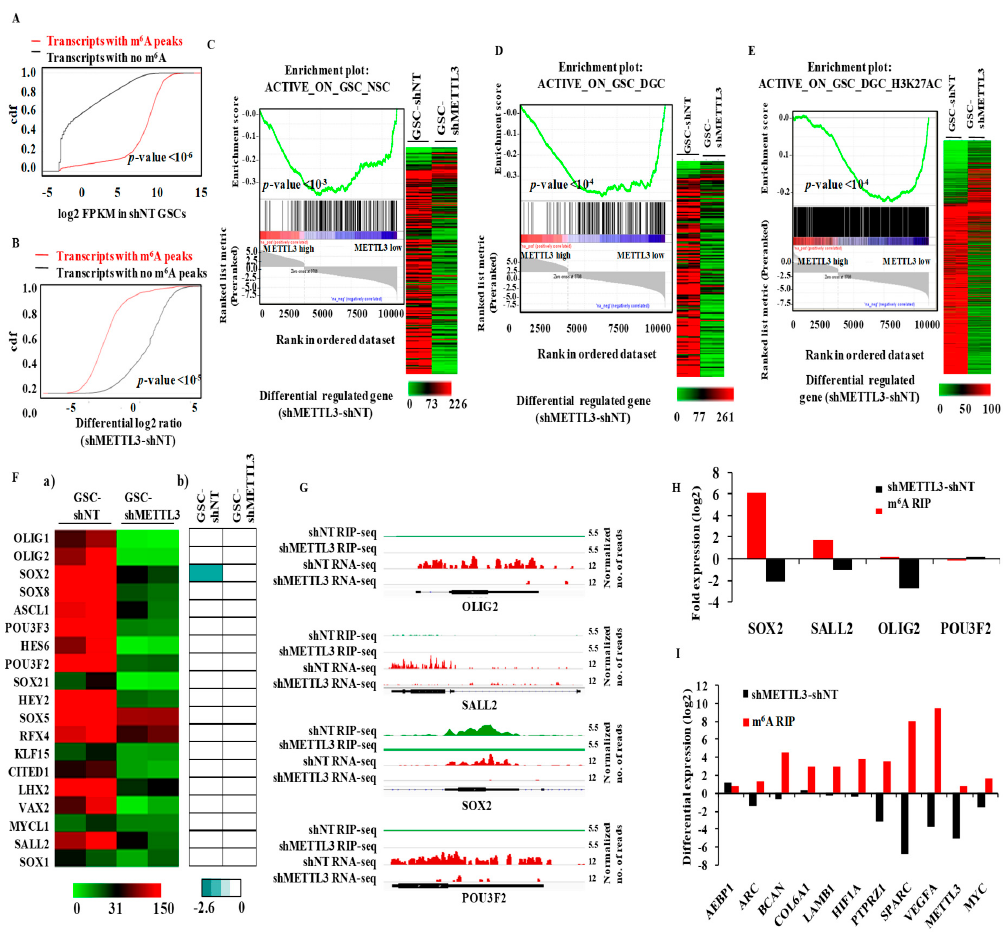
Figure 2. Functional coordination of direct METTL3 targets with epigenetic/transcriptional activation. ( A ) The abundance of m 6 A-modified transcripts was compared with non-modified transcripts. FPKM (fragments per kilobase of transcript per million mapped reads) of each group was shown as cumulative fraction. m 6 A modified transcripts were high in expression. ( B ) The cumulative distribution of fold change (shMETTL3-shNT) among methylated transcripts and unmethylated genes was compared. Methylated targets were significantly inhibited by METTL3silencing compared to unmethylated genes ( p -value = 0.00001). ( C ) (Left panel) Gene set enrichment analysis (GSEA) enrichment plot showed a depletion of the GSC-specific transcriptionally activated gene set (ACTIVE_ON_GSC_NSC) compared to Neuronal stem cells (NSC) in METTL3-regulated targets (shMETTL3-shNT). The active gene set contained genes with H3K4me3 (active mark) in their promoters. (Right panel) The normalized read counts of genes (shNT-GSC and shMETTL3-GSC) that were enriched for the ACTIVE_ON_GSC_NSC gene set are depicted as heatmap. Red and green denotes high and low expression, respectively. The majority of genes that are activated by active histone mark in GSCs were downregulated in METTL3-silenced condition. ( D ) (Left panel) GSEA enrichment plots showing a depletion of the GSC-specific transcriptionally activated gene set (ACTIVE_ON_GSC_DGC) compared to Differentiated glioma cells (DGC) in METTL3-regulated targets (shMETTL3-shNT). The active gene set contained genes with H3K4me3 (active mark) in their promoters. (Right panel) The normalized read counts of genes (shNT-GSC and shMETTL3-GSC) that were enriched for the ACTIVE_ON_GSC_DGC gene set are depicted as heat map. Red and green denotes high and low expression, respectively. The majority of genes that are activated by active histone mark in GSCs were downregulated in METTL3-silenced condition. ( E ) (Left panel) GSEA enrichment plots showing a depletion of the GSC-specific transcriptionally activated gene set (ACTIVE_ON_